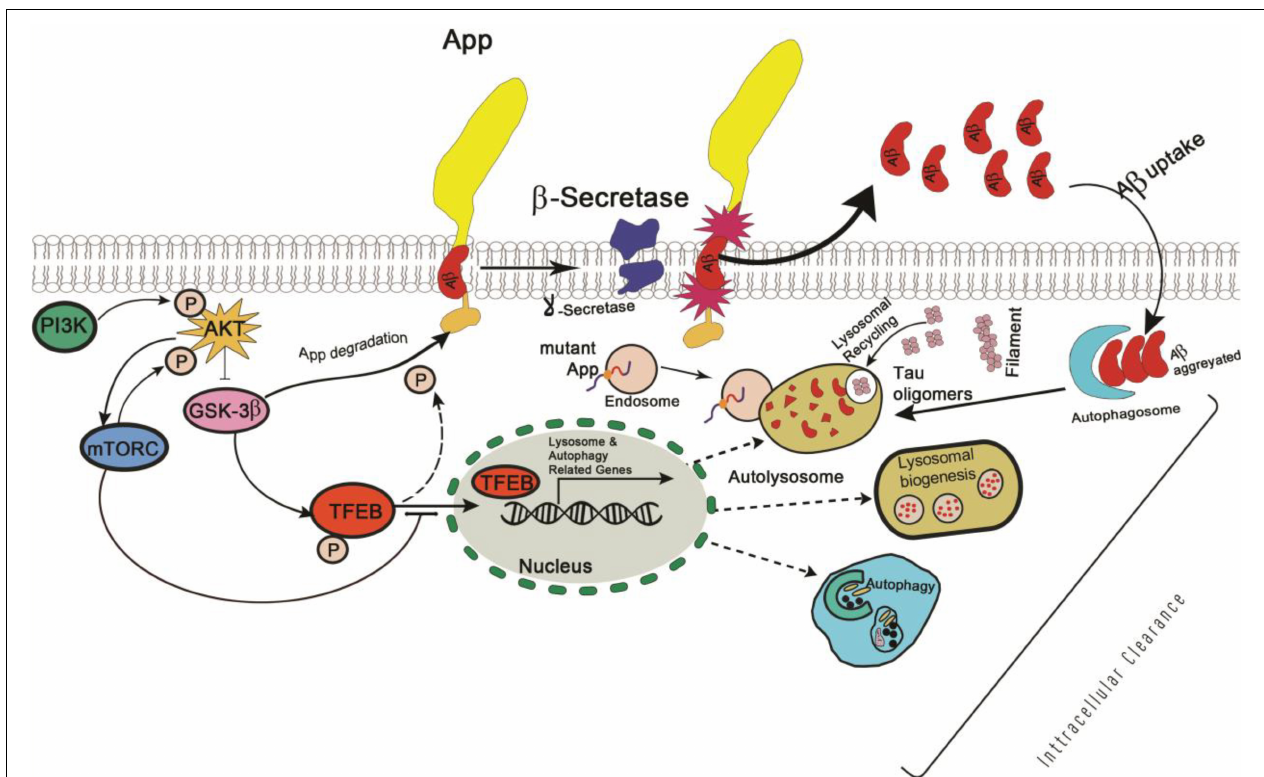
FIGURE 2 | Schematic representation of PI3K/AKT/GSK-3 β mediated phosphorylation signaling pathway in Alzheimer’s